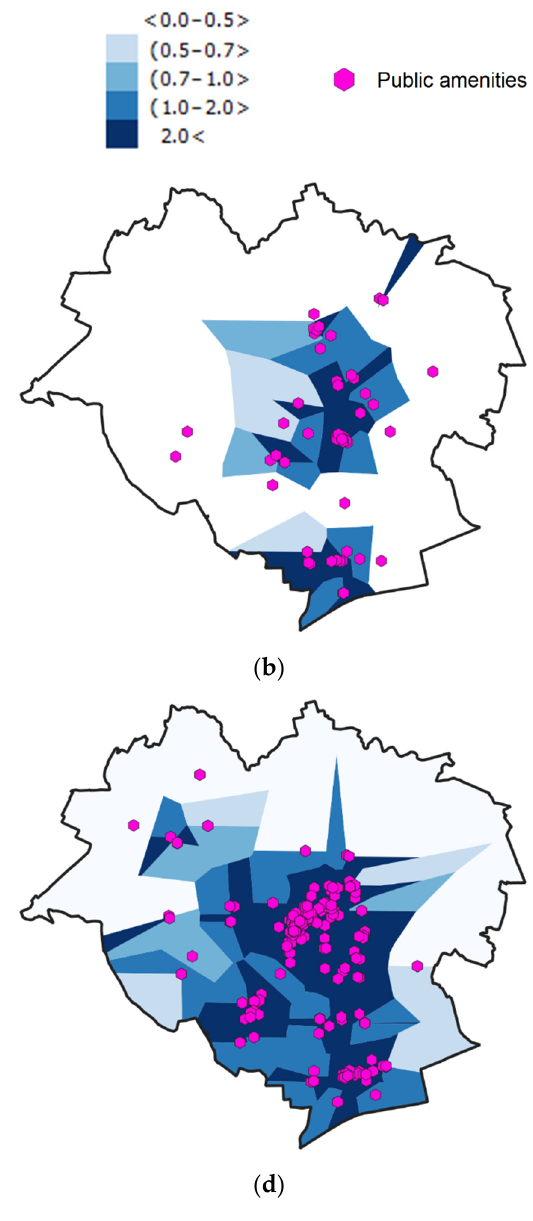
Figure 5. Spatial accessibility of selected public amenities in Olsztyn [units/km 2 ], part 1. Source: own elaboration . ( a ) Pharmacies; ( b ) Health care facilities; ( c ) Churches; ( d ) Restaurants .